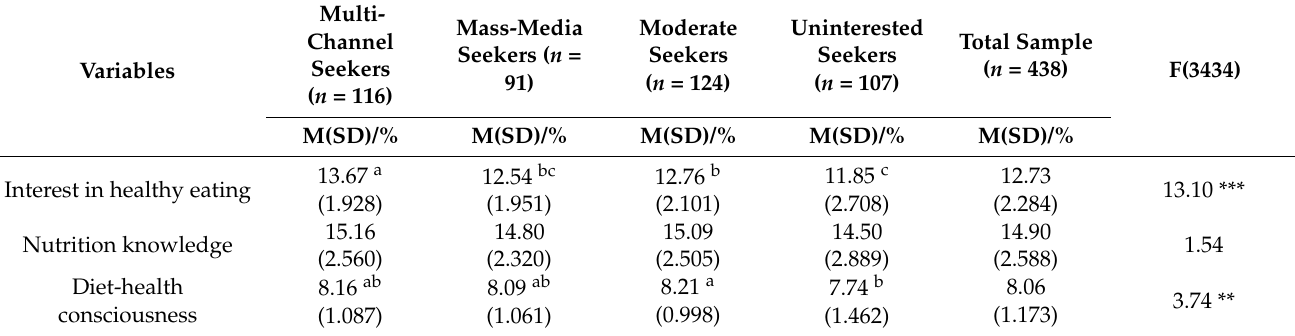
Table 2. Food literacy of the four